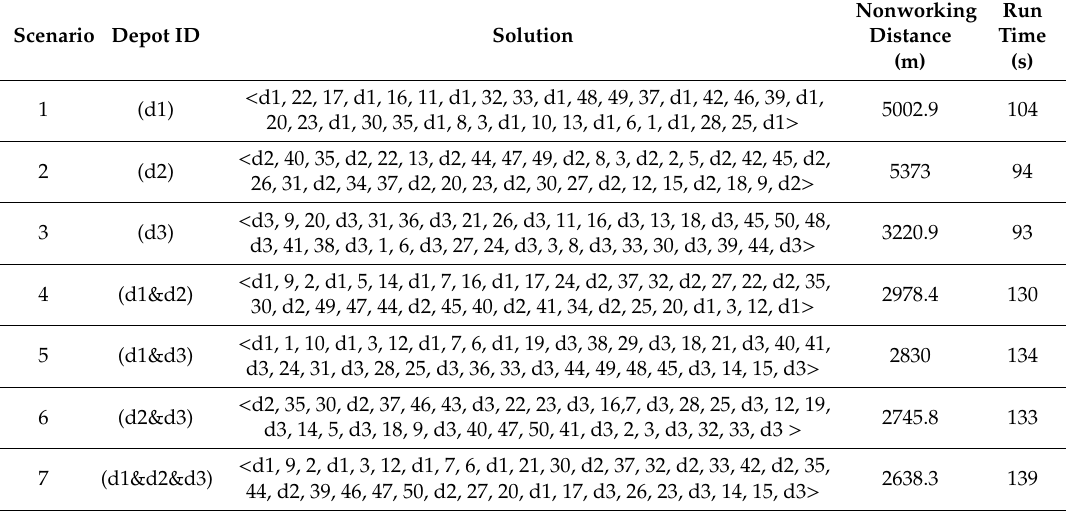
Table 7. Comparison of scenarios for the case study